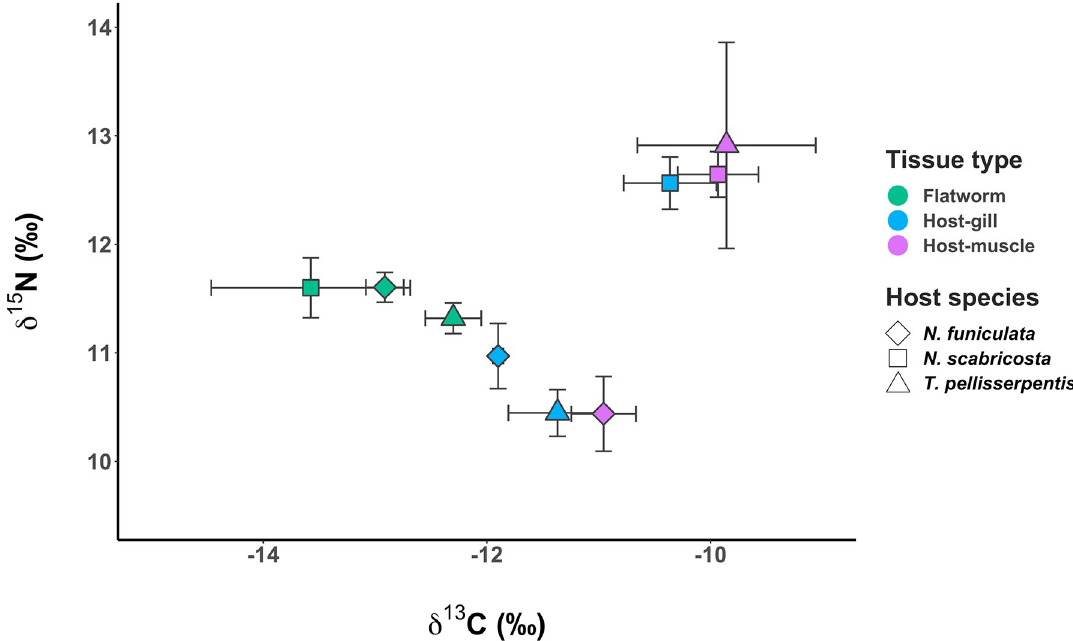
Fig 5. Stable isotope analysis of flatworm and snail tissues. Tissue δ 13 C and δ 15 N of flatworms and their snail host species: Nerita funiculata (diamond), N . scabricosta (square), and Tegula pellisserpentis (triangle). Different colors represent tissues sampled from flatworm (emerald green), snail gill (light blue), and snail mantle and foot muscle (purple pink). Sample size was n = 4 − 8 for each snail species × tissue category. Error bars indicate 1